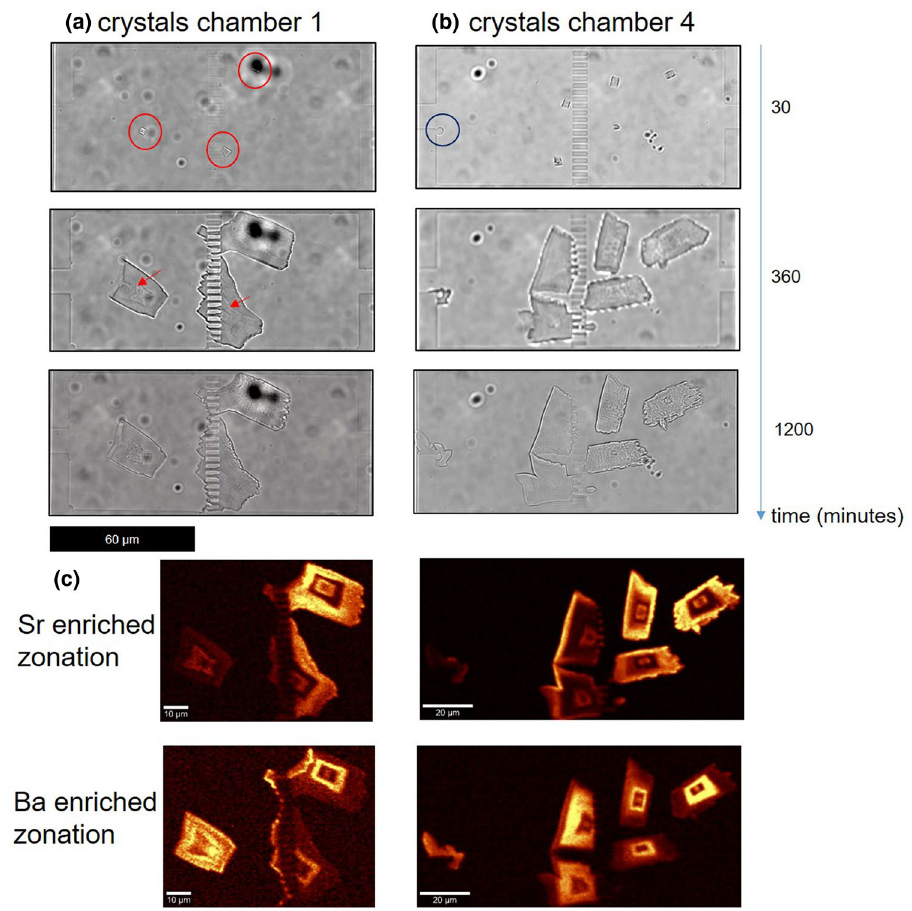
Figure 2. Temporal evolution of crystals in chamber 1 ( a ) and 4 ( b ) as revealed by optical microscopy. Image ( c ) shows hyperspectral Raman images of the ν 1 (SO 4 ) intensities from crystals formed after 1200 min in chamber 1 and 4 with intensities of 1000 ± 3 and 994 ± 3 cm −1